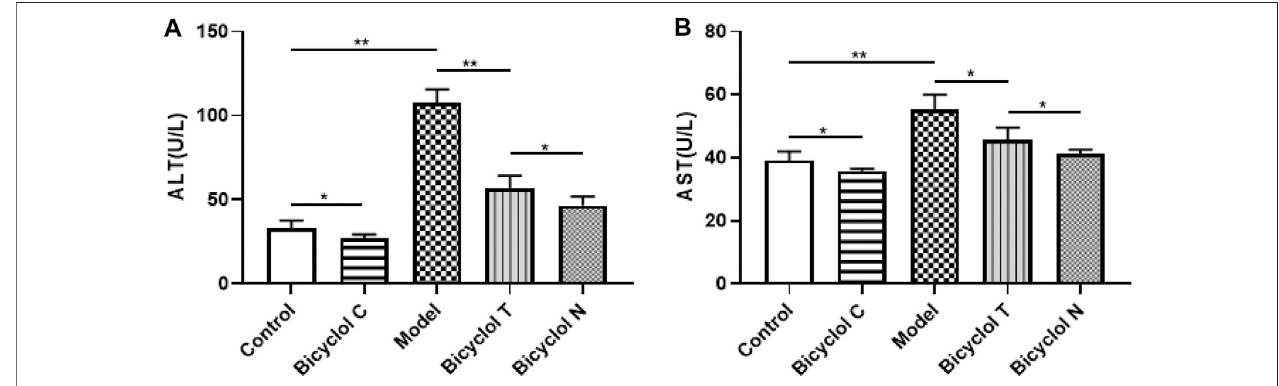
FIGURE 4 | Effect of bicyclol on ALT and AST levels in T2DM – NAFLD rat (A) ALT. (B) AST. Data are presented as means ± SD. * p < 0.05. ** p <